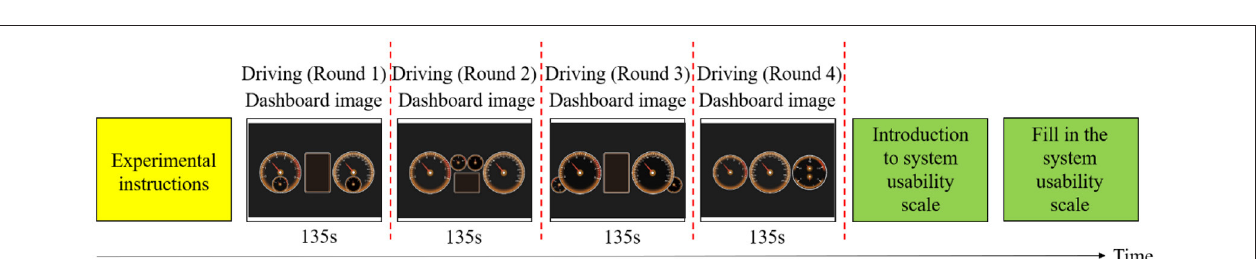
FIGURE 3 | Workflow diagram of the